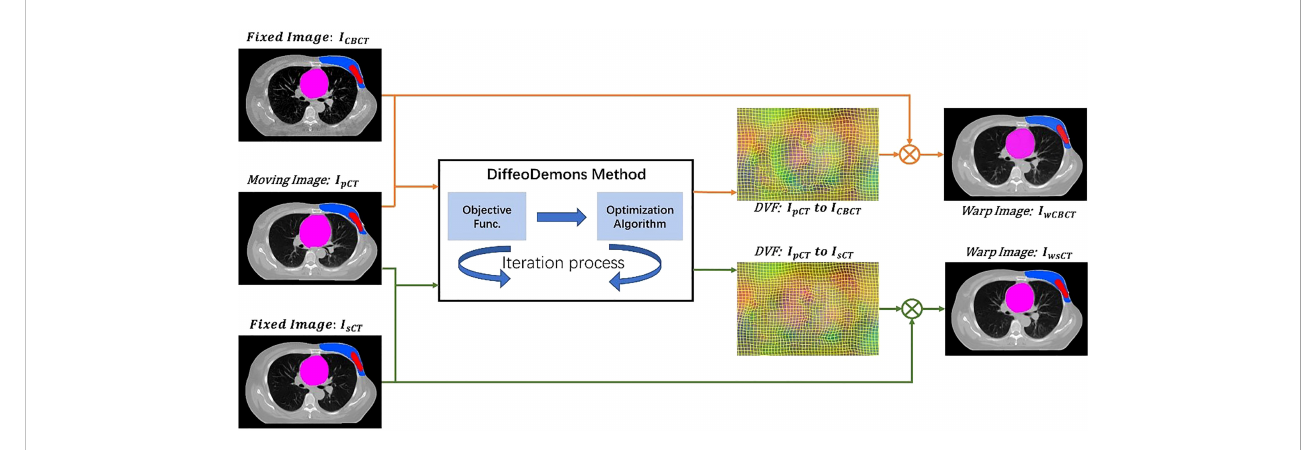
FIGURE 2 The image registration process with two different